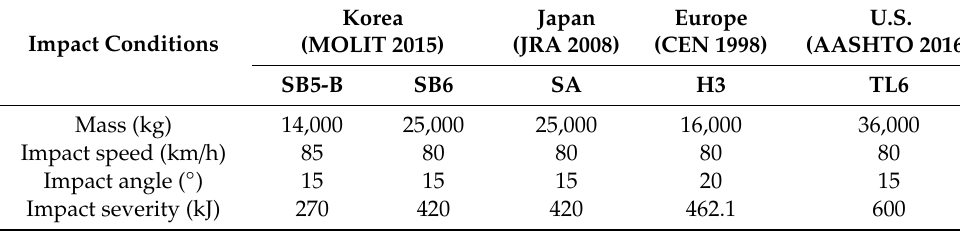
Figure 10. Comparison of impact severity (IS) among developed countries [25–27]. Table 2. Comparison of impact test conditions among developed countries [25–28].